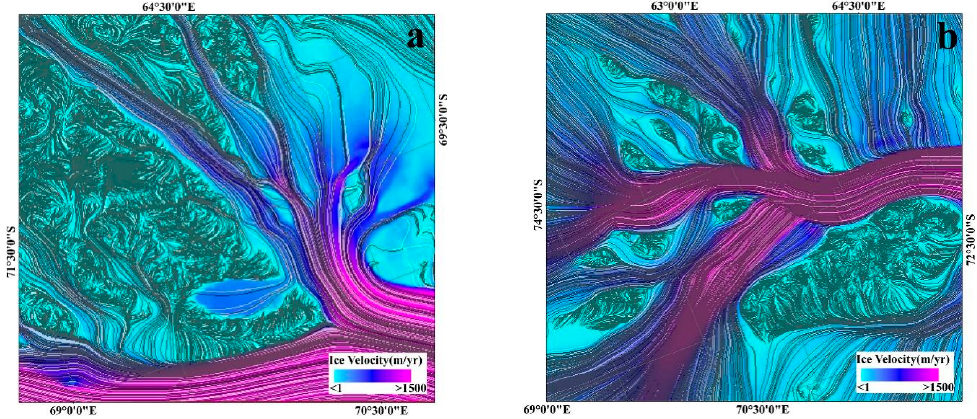
Figure 9. Comparison of flow lines between the proposed method and the method using only angular and distance differences, the black line shows the method in this paper and the white line shows the method using only angular and distance differences. ( a ) Comparison of flow lines between the proposed method and the method using only angular and distance differences (case #3). ( b ) Comparison of flow lines between the proposed method and the method using only angular and distance differences (case #4).